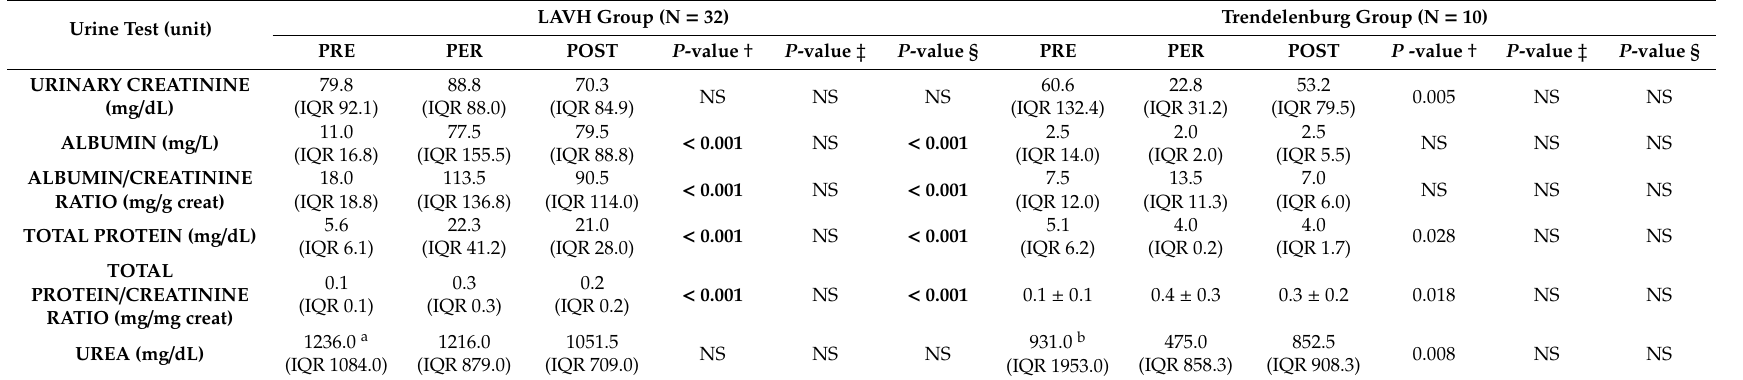
Table 2. Comparison of urinary renal function parameters PRE-, PER- and POST-procedure within each